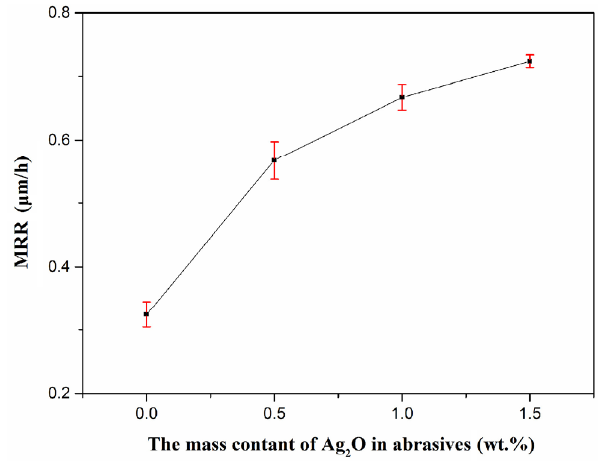
Fig. 4 The relationship between MRR and the mass content of Ag 2 O in abrasives (red line is the error